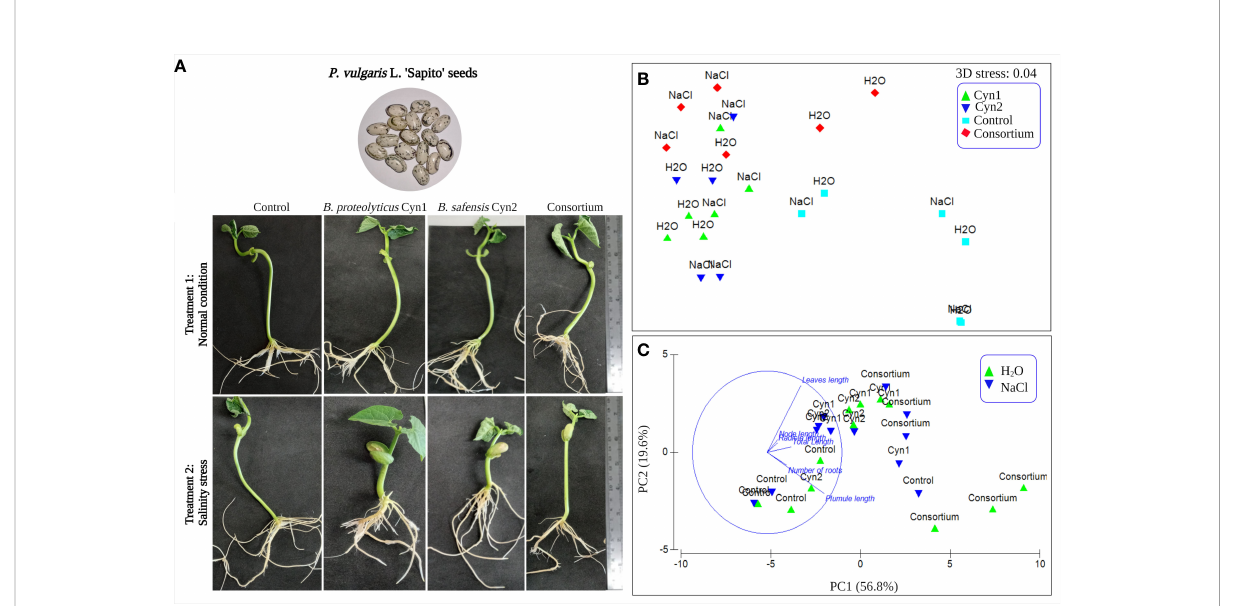
FIGURE 6 (A) Effect of seed bacterization on the growth of “ Sapito ” variety common beans, where treatment 1 is the normal condition and treatment 2 under introduced salinity stress (5%), respectively for control without any inoculation, and inoculation Cyn1, Cyn2, and consortium. (B) NMDS plot with a 3D stress of 0.04. (C) Principal component analysis results loading plot PC1 (56.8%) and PC2 (19.6%) variances.